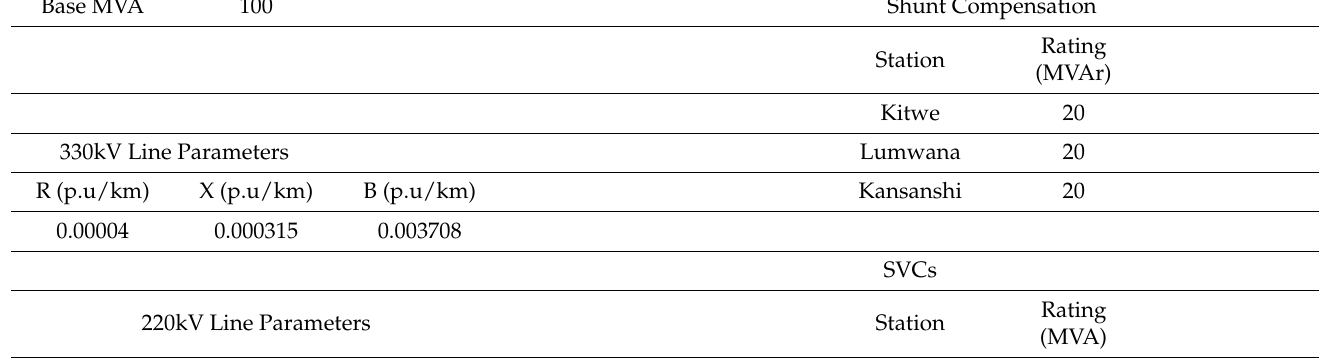
Figure A3. Layout showing the PSAT FPV and wind integration model for the 330 kV Zambian network. Table A4. Showing the power system modeling